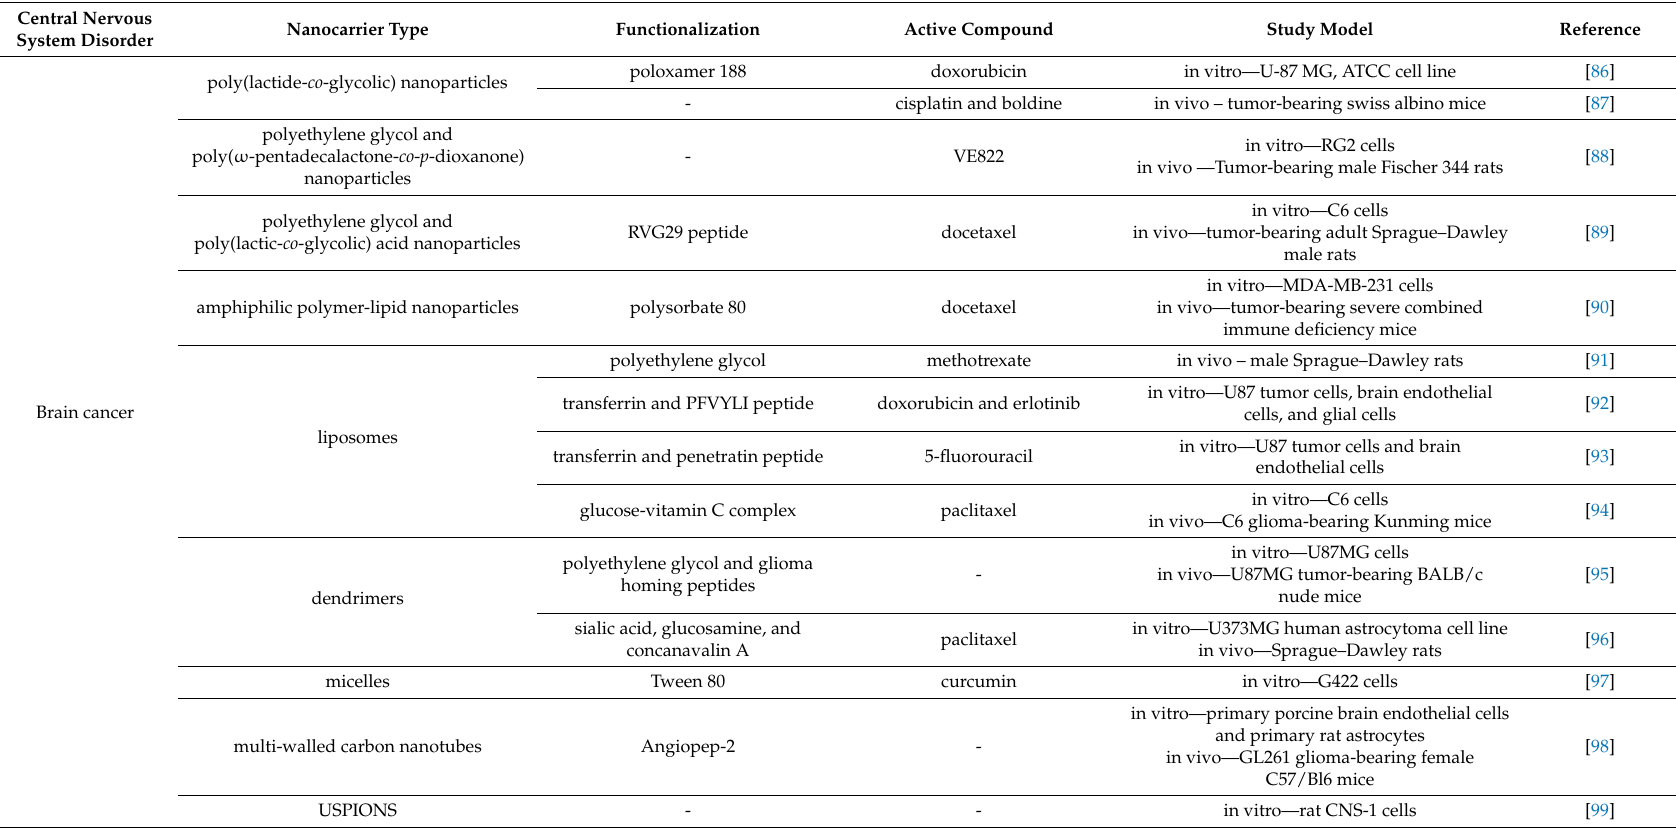
Table 3. A summary of the nanotechnology-based treatment strategies for brain cancer, neurodegenerative diseases, and